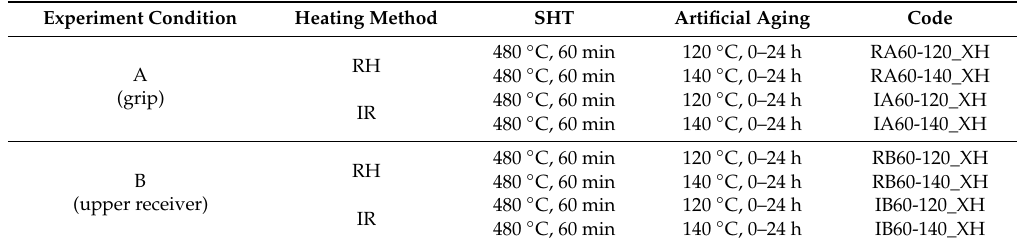
Table 3. Experimental parameters and specimen codes.